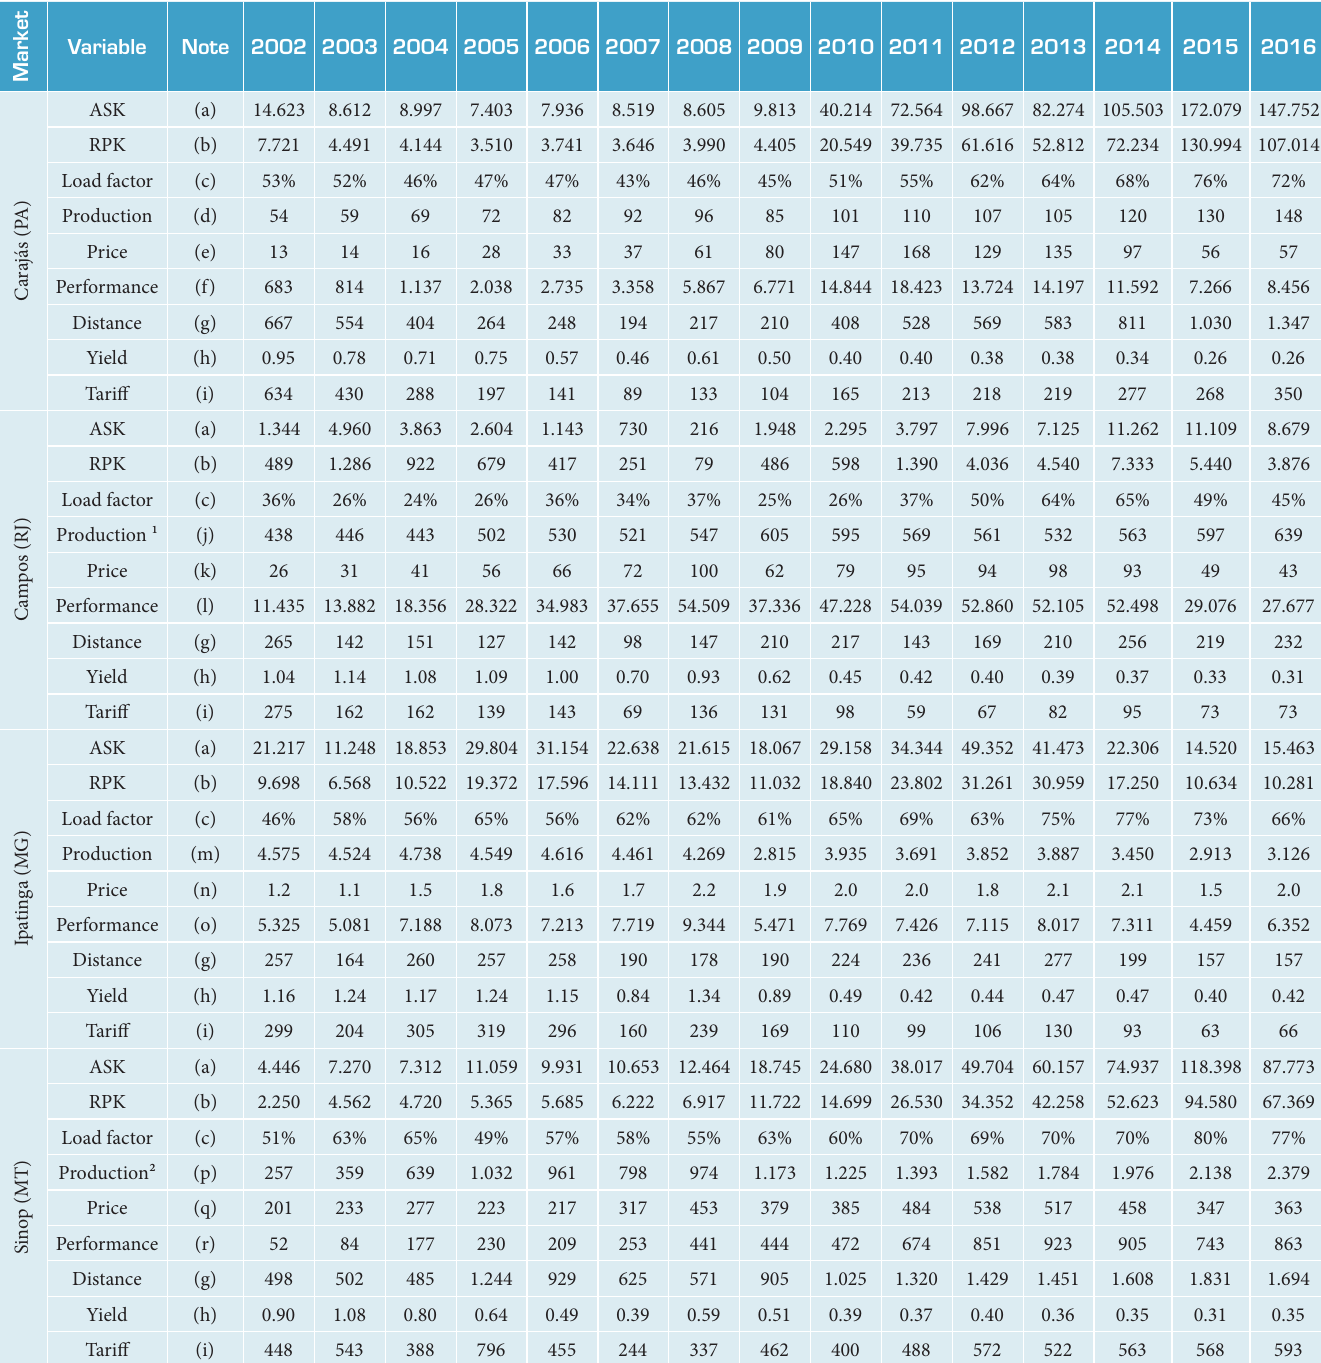
Table 1. Commodity production levels, average tariff and supply and demand for passenger air transport in the production areas.